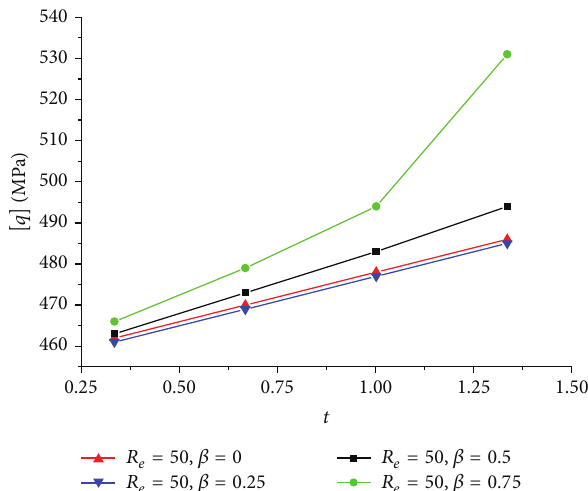
Figure 7: Experimental and theoretical results of the ultimate axial compressive stress of the specimens.